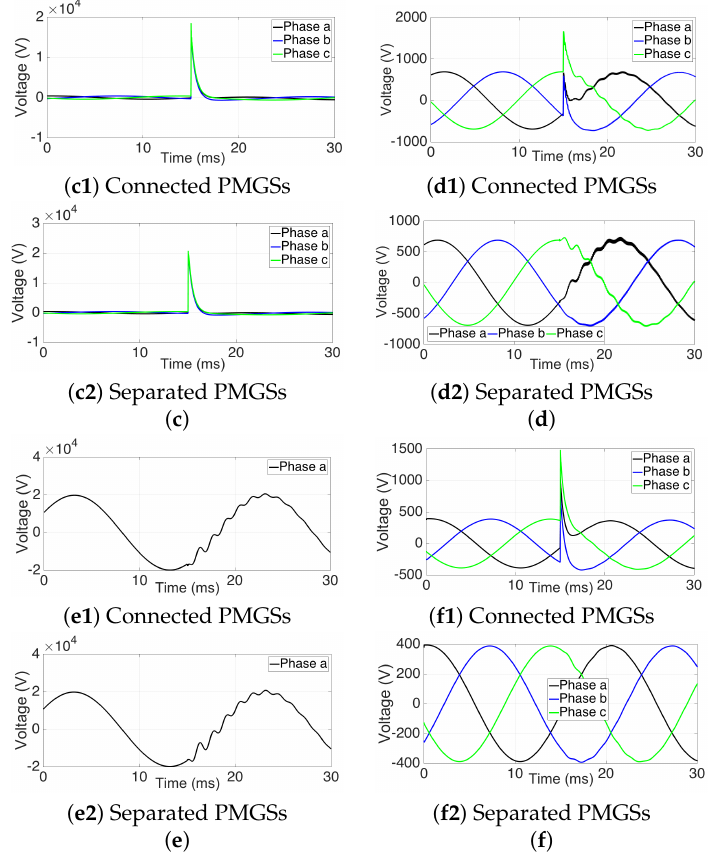
Figure 16. Impact of indirect lightning on overvoltages. ( a ) LV side of the first tower; ( b ) HV side of the first tower; ( c ) control circuit of the first tower; ( d ) LV side of the second tower; ( e ) HV side of the second tower; ( f ) control circuit of the second